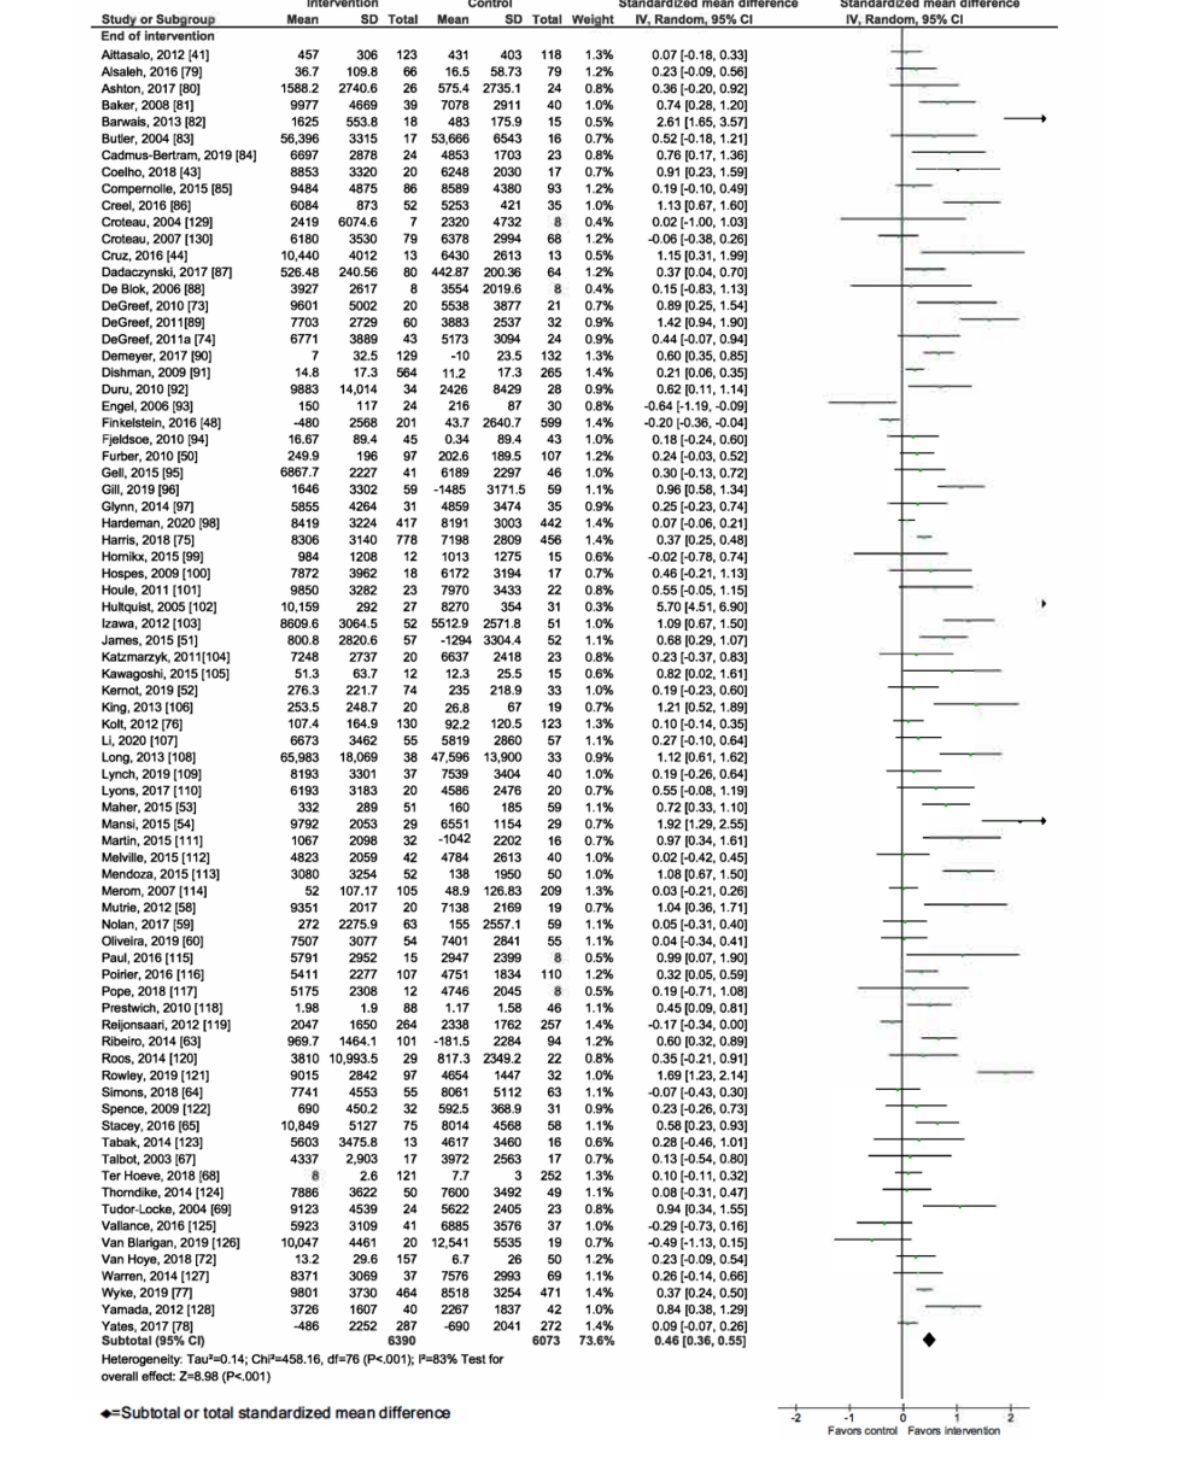
Figure 2. Primary outcome analysis for the outcome walking at timepoint end of